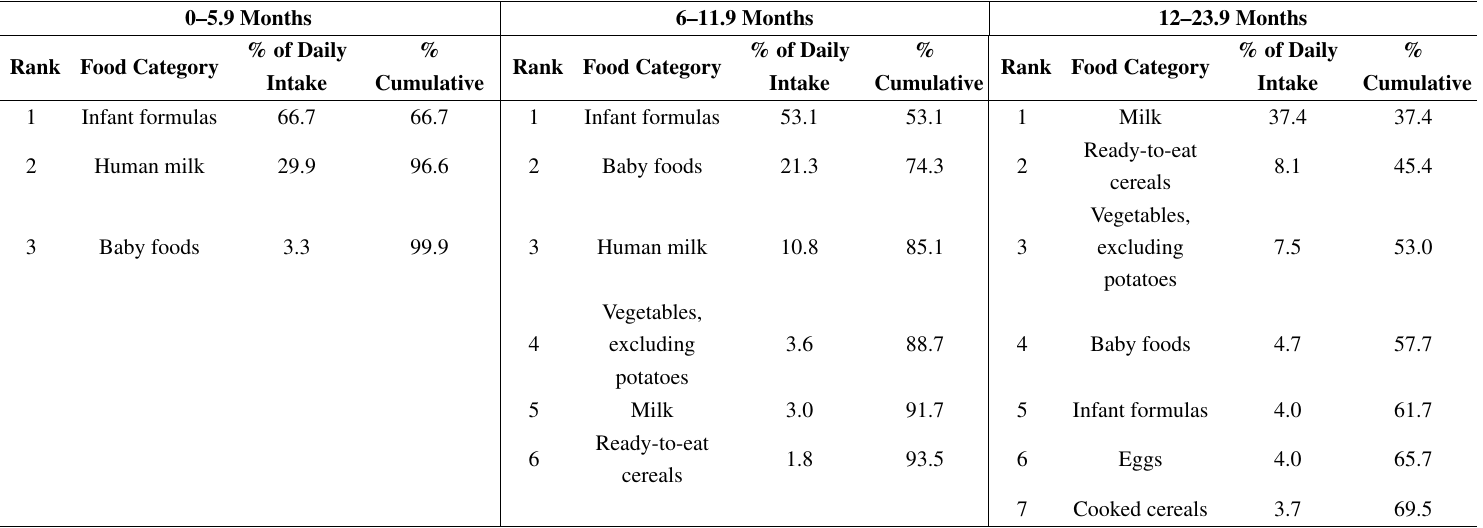
Table 9. Food sources of Vitamin A among US infants and toddlers aged 0–23.9 months by age group: NHANES 2005–2012 ( n = 2740) a